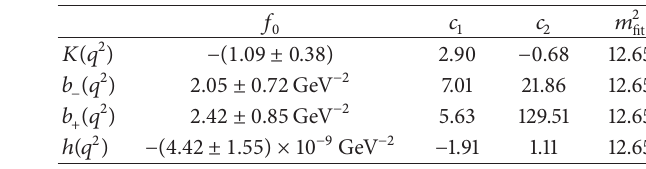
Table 1: Parameters appearing in the fit function of the form factors.